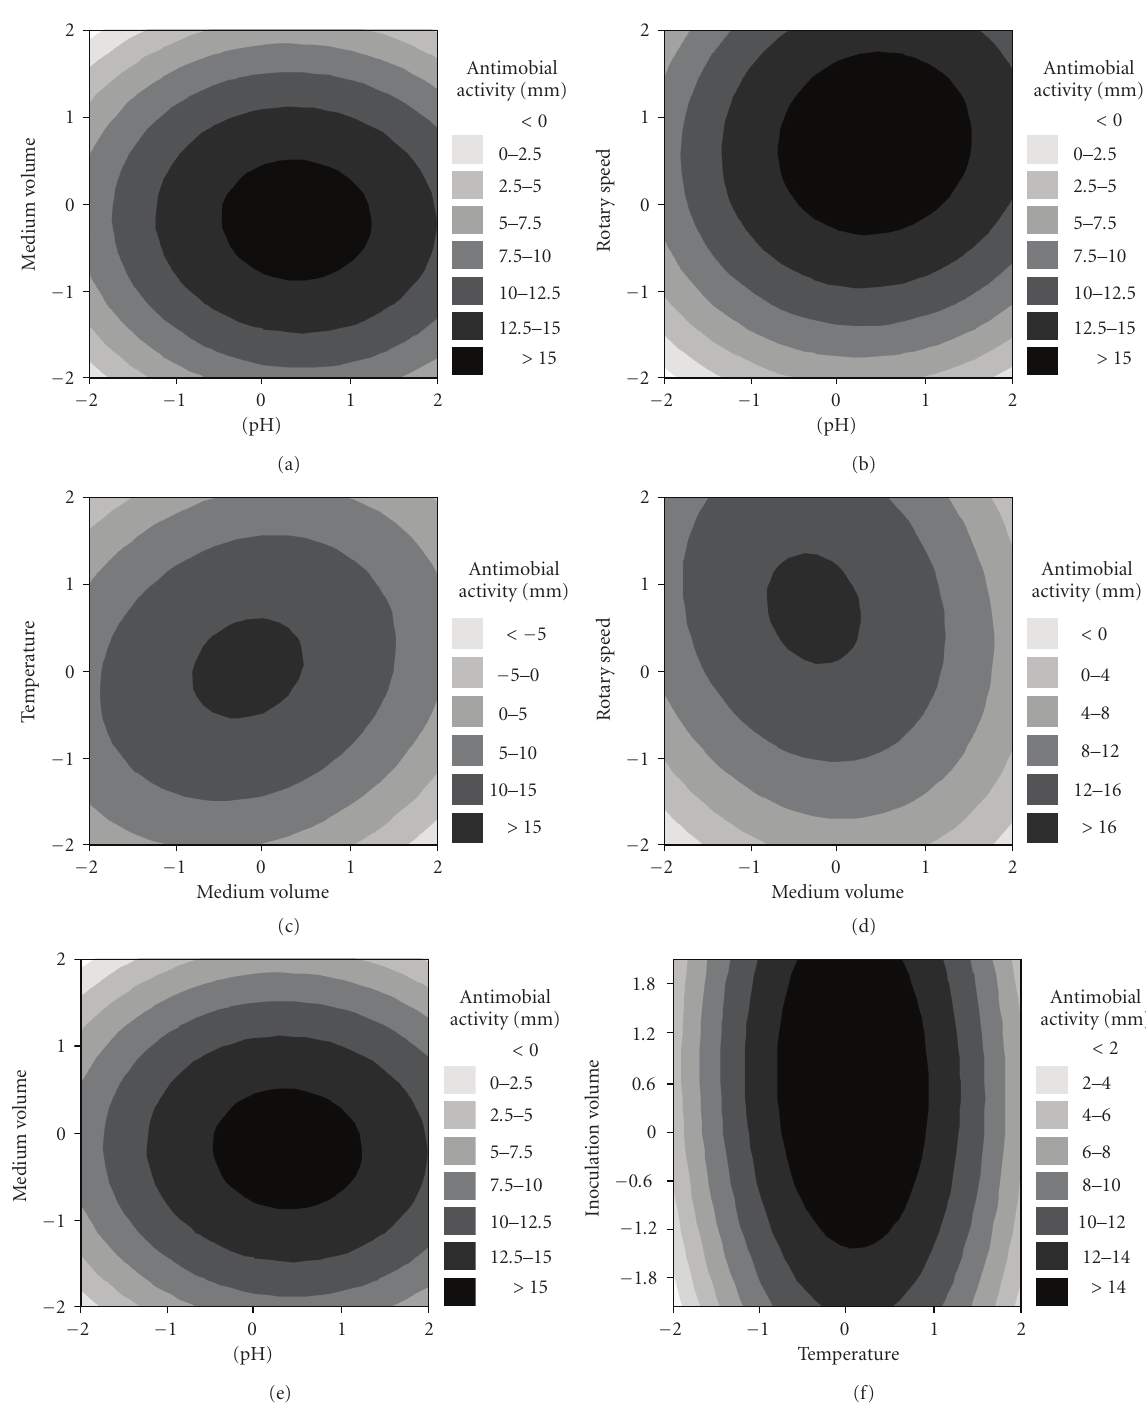
Figure 3: Contour plot of antimicrobial activity produced by strain Hhs.015 T (mm). (a): the e ff ect of pH and medium volume on production of components with antimicrobial activity. (b): the e ff ect of pH and rotary speed on synthesis of antimicrobial active compounds. (c): the e ff ect of medium volume and temperature on production of antimicrobial active components. (d): the e ff ect of medium volume and rotary speed on production of antimicrobial active compounds. (e): the e ff ect of medium volume and inoculation volume on synthesis of antimicrobial active compounds. (f): the e ff ect of temperature and inoculation volume on production of antimicrobial active components. Because a contour plot showed only two factors; the other factors were held constant at a middle level. The darkest area indicated the contour where the response is the highest. The range of pH was − 2 (2.0), − 1 (4.5), 0 (7.0), 1 (9.5), 2 (12). The range of medium volume (mL/250mL) was − 2 (30), − 1 (60), 0 (90), 1 (120), 2 (150). The range of rotary speed (rev/min) was: − 2 (0), − 1 (50), 0 (100), 1 (150), and 2 (200). The range of temperature ( ◦ C) was − 2 (15), − 1 (20), 0 (25), 1 (30), 2 (35). The range of inoculation volume (%) was − 2 (8), − 1 (11), 0 (14), 1 (17), and 2